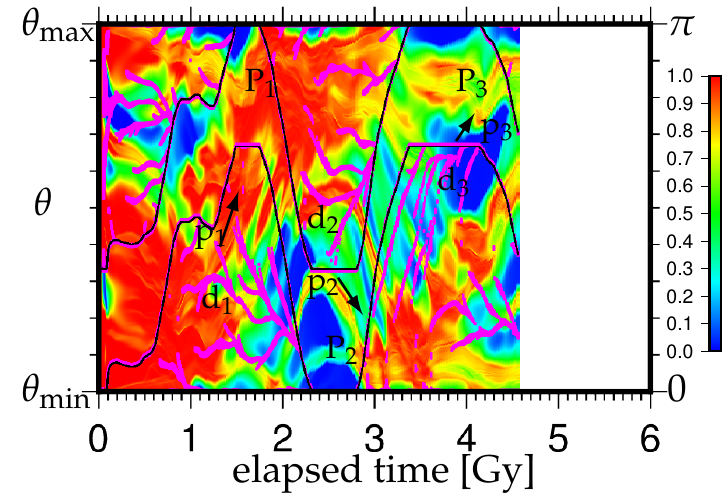
Figure 8. Temporal evolution as a function of the horizontal coordinate θ of composition c averaged over a d /16 ( = 181.25 km) depth just above the bottom surface for Case 4. For the color scale for the distributions of c , see the scale bar in the right of the figure. The two black lines indicate the positions of the margins of the continental lid as a function of the elapsed time (i.e., θ = θ lid ± w lid /2), while purple dots indicate the positions of cold descending flows at the top surface for given elapsed times. See the text for the meanings of the labels “P 1 ”–“P 3 ”, “p 1 ”–“p 3 ” and “d 1 ”–“d 3